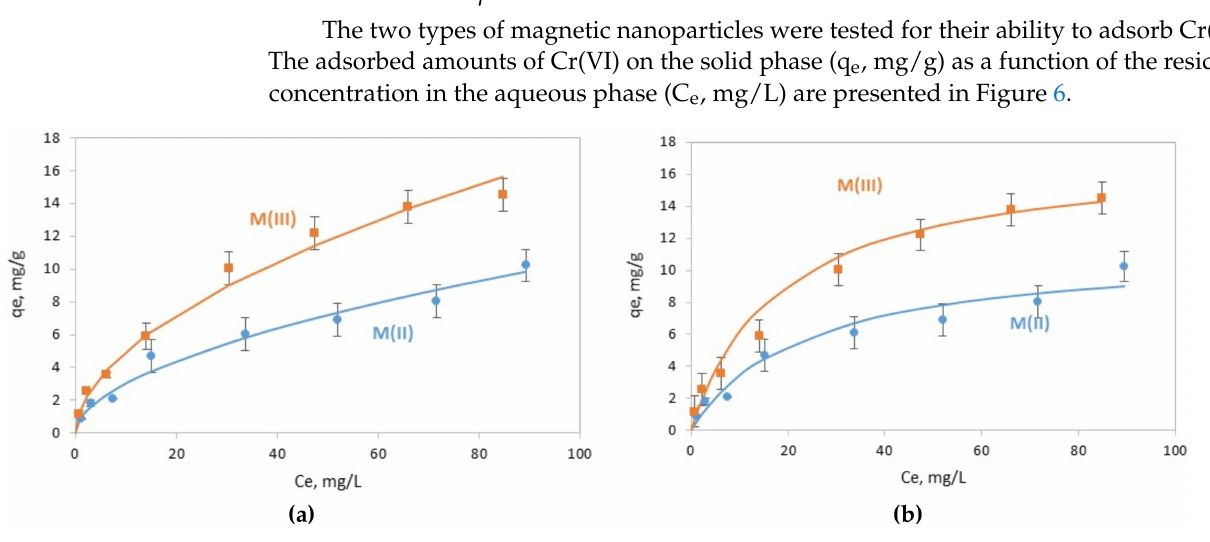
Figure 6. Adsorption of C(VI) by M(II) and M(III) nanoparticles. Fitting curves with ( a ) Freundlich and ( b ) Langmuir